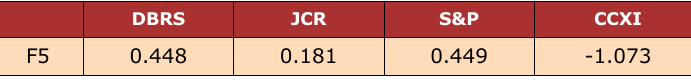
Table 14. The Assessment Value of Competitiveness